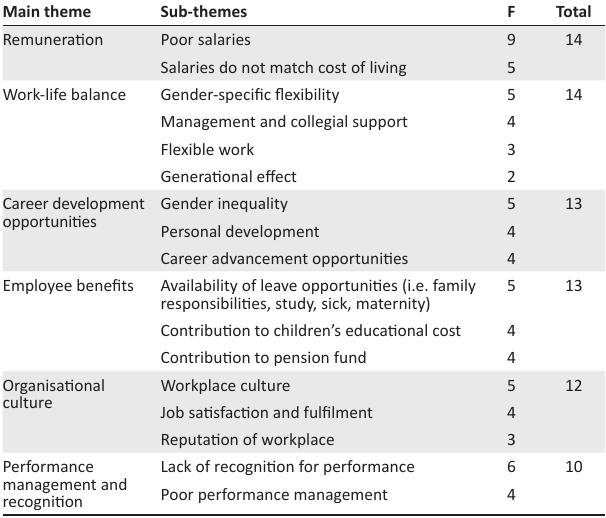
TABLE 1: Categories of main and